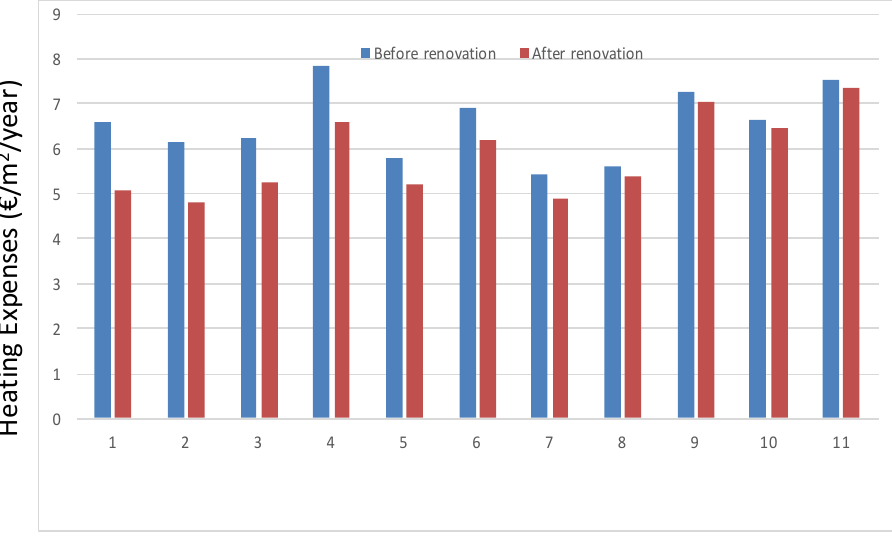
Figure 5. Impact of renovation of Category E buildings on the heating expenses.